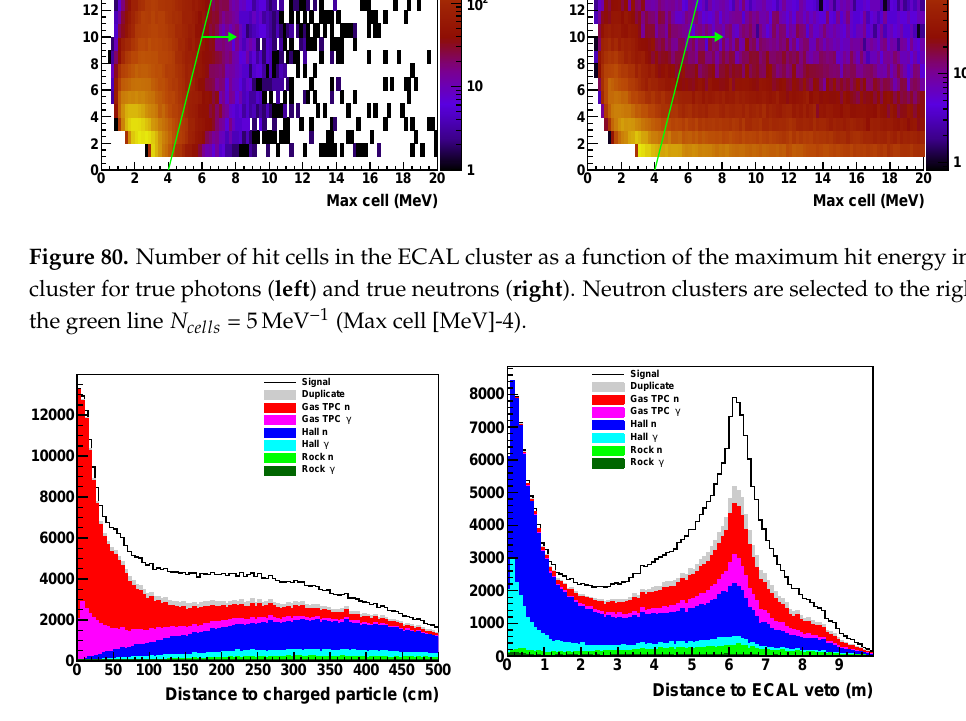
Figure 81. On the ( left ), the distribution of the cluster distance to a charged track for RHC mode. Events are categorized based on the origin of the cluster (neutron or photon), whether that particle comes from the signal neutrino interaction or not. Uncorrelated backgrounds are further divided into those coming from the rock and from the rest of the detector hall. A cut is made at 70cm. On the ( right ), the distribution of the distance of a cluster to any ECAL activity restricted to be 15ns apart for RHC mode. The signal peaks at 6m due to the fact that the signal is preferably forward and more probably observed downstream in the ECAL. The background is preferably upstream in the ECAL. A cut is made at 2m.